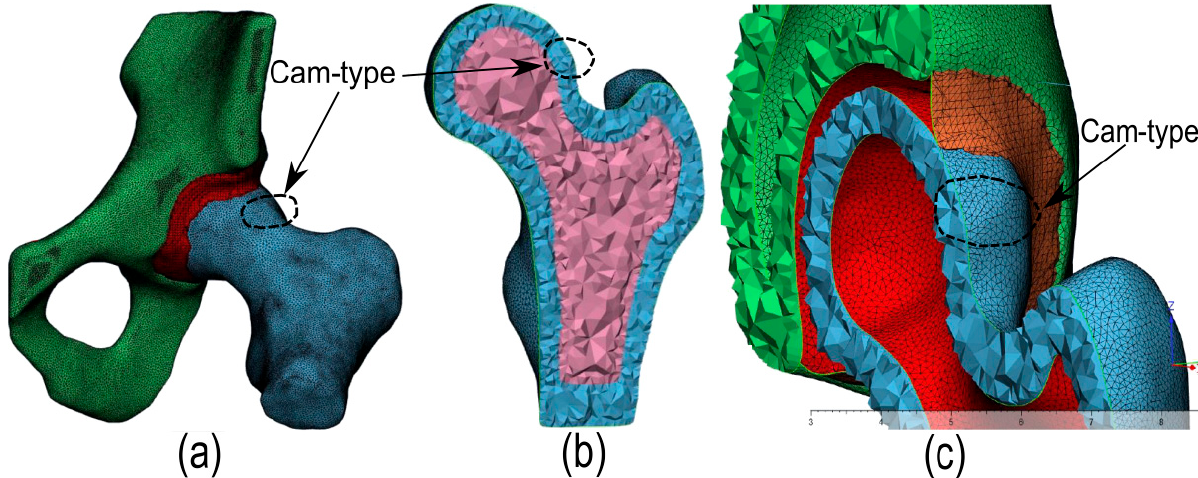
Figure 5. Mesh imported into the Mentat-Marc ® software: ( a ) FE model with hip joint damaged (with CAM), ( b ) details of the femur and ( c ) details of the pelvis and cartilage. Table 2. The number of elements and nodes of the pelvis, femur, and cartilage of the healthy and Cam-type hip joints, considering a mesh size of 0.65 mm.